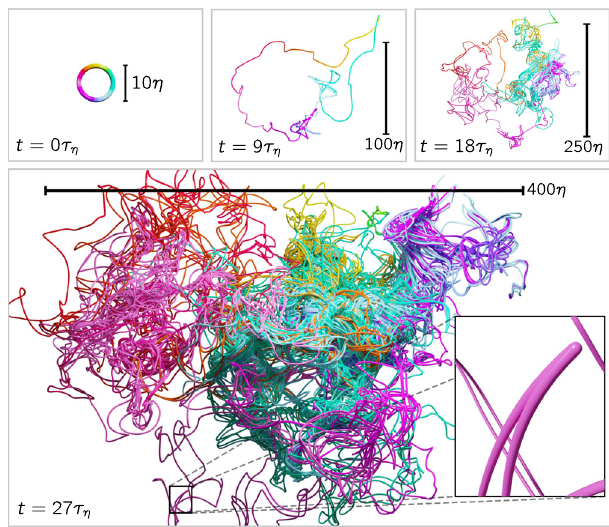
Fig. 1 Visualization of material loop evolution. The initially circular loop (color corresponds to initial angle) is advected by a turbulent fl ow fi eld for 27 τ η , where τ η is the Kolmogorov time. The twisting and folding action of the turbulent fl ow creates a complex loop geometry while the length of the loop increases exponentially on average (cf. Fig. 3). The loop shown is a comparably extreme case; loops in less turbulent regions develop an extended and complex structure after a longer time. Inset: material fold causing a peak of curvature. (See also Supplementary